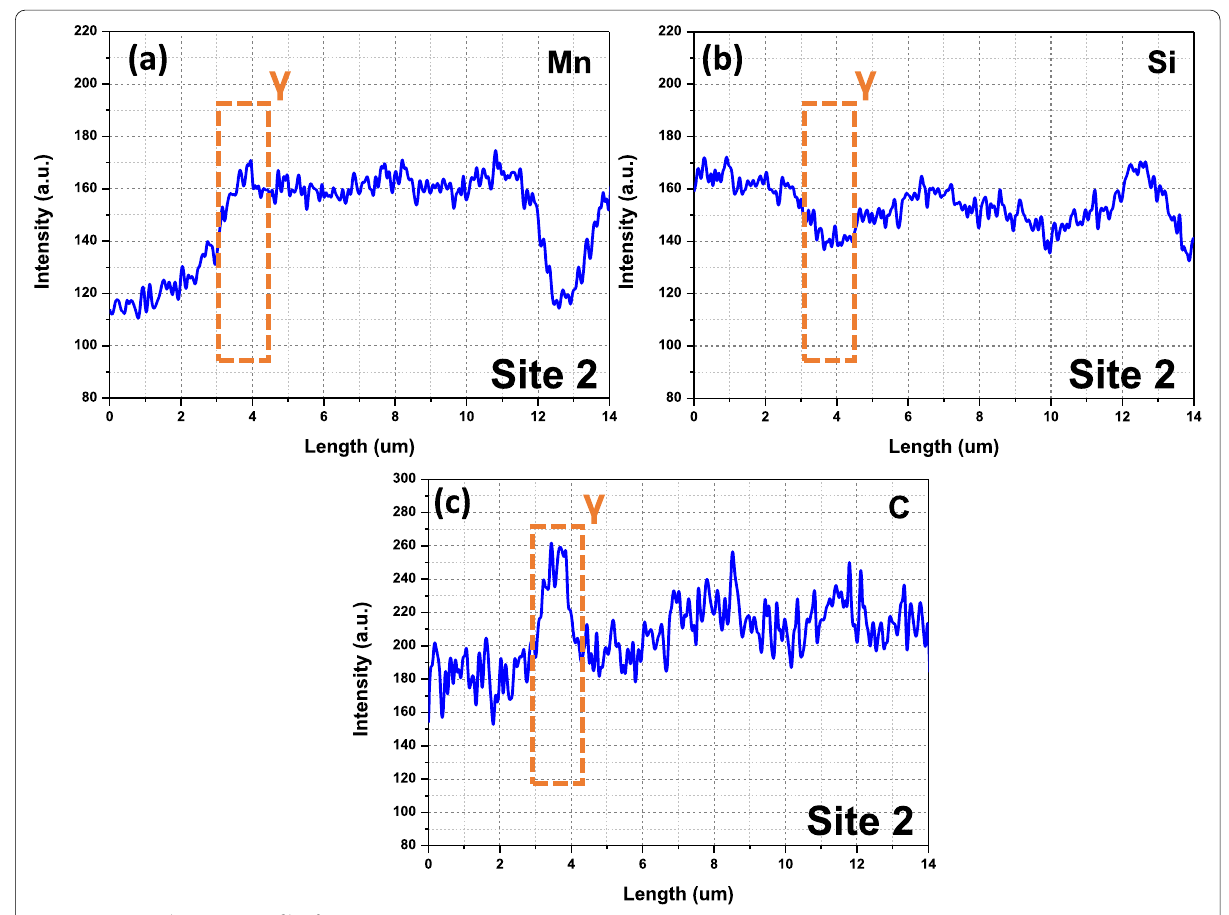
Fig. 10 Extracted intensity profiles from site 2 in Fig. 7c to e